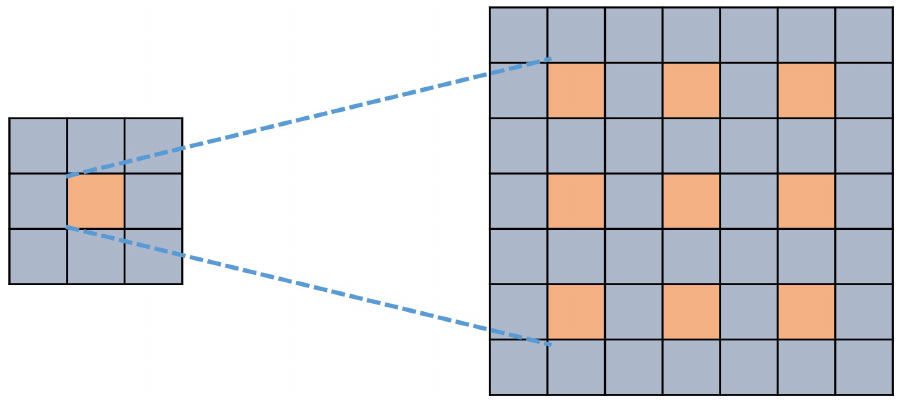
Figure 8. Atrous convolution structure.